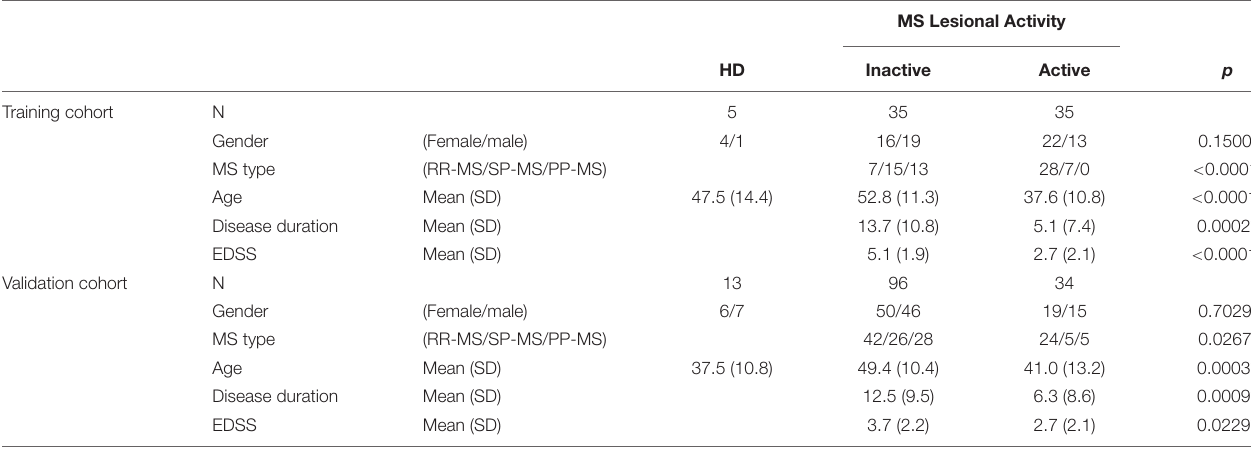
TABLE 1 | Demographic details of training and validation cohorts. Across MS lesional activity subgroups (inactive versus active) categorical variables (gender and MS disease type distributions) were compared using Chi-square test ( ∗ ) and continuous variables (age, disease duration, and EDSS) were compared using t -test ( # ).